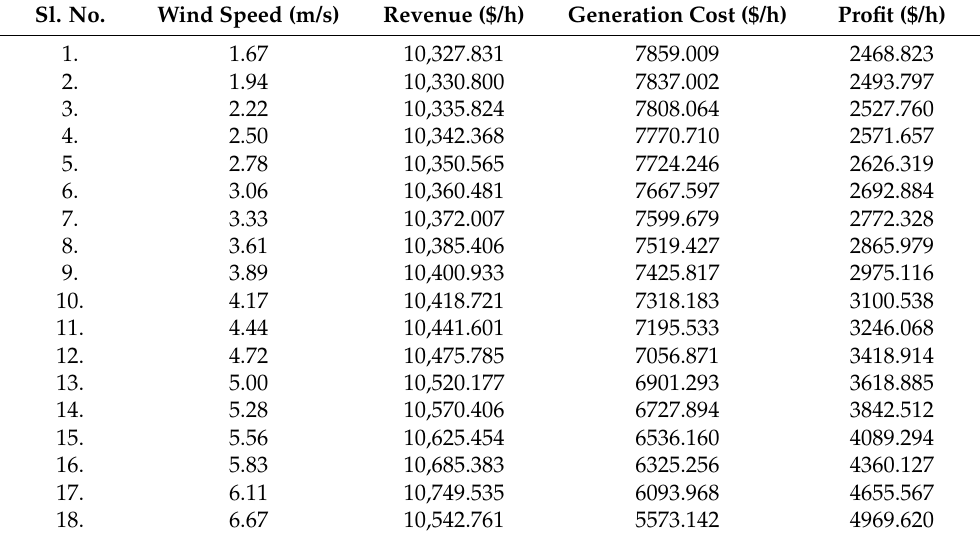
Table 5. Calculation of revenue and generating costs with wind integration.